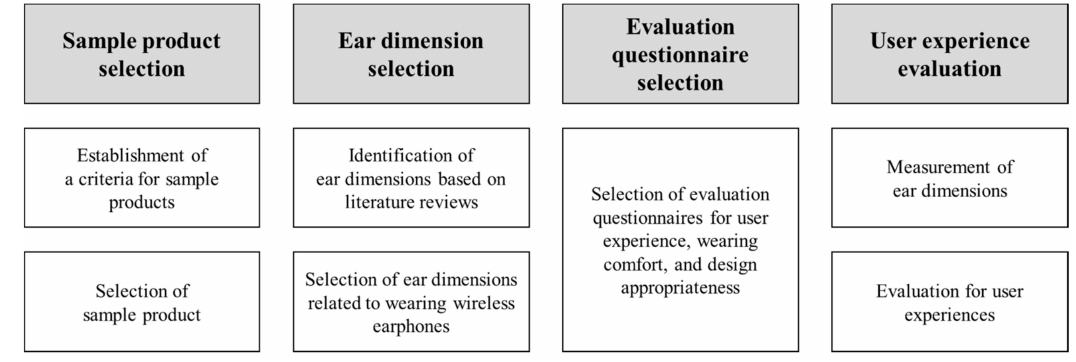
Figure 1. Overall process of the study.